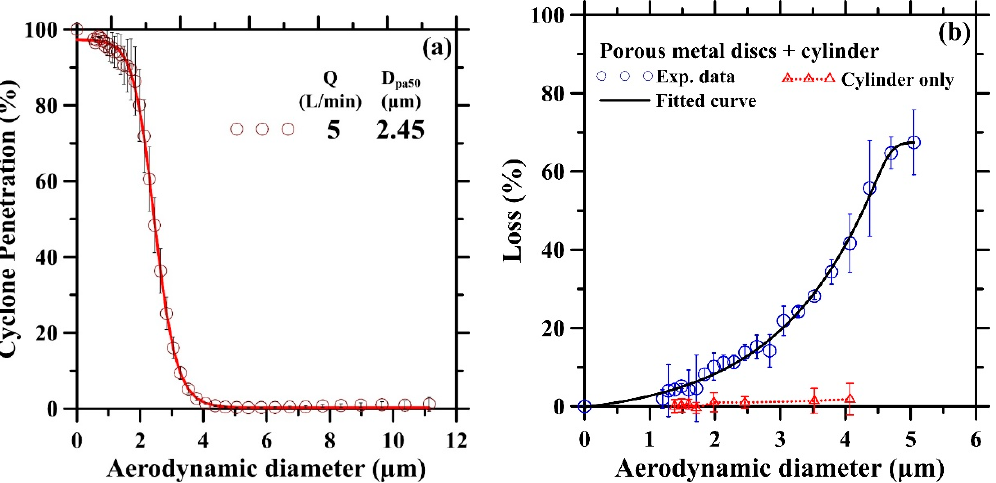
Figure 3. ( a ) Penetration curve and ( b ) particle loss of the 5 L / min PDS.